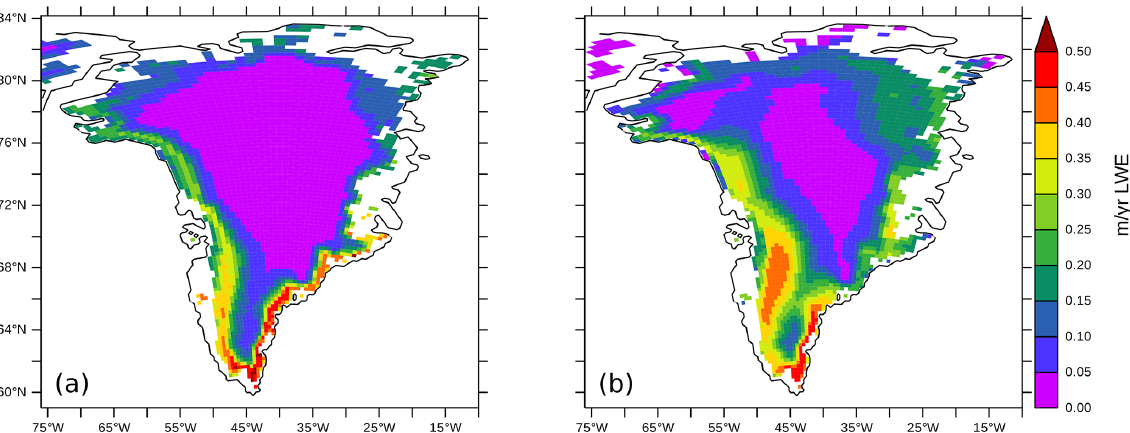
Figure 7. Annual average internal snowpack refreezing (myr − 1 LWE) for Greenland in (a) MAR (1980–1999, maximum 0.59) (Fettweis et al., 2013) and (b) FAMOUS-ice (maximum 0.56). To visualise the distribution on sub-grid-scale tiles, FAMOUS-ice results have been trilinearly mapped to the same topography as used in